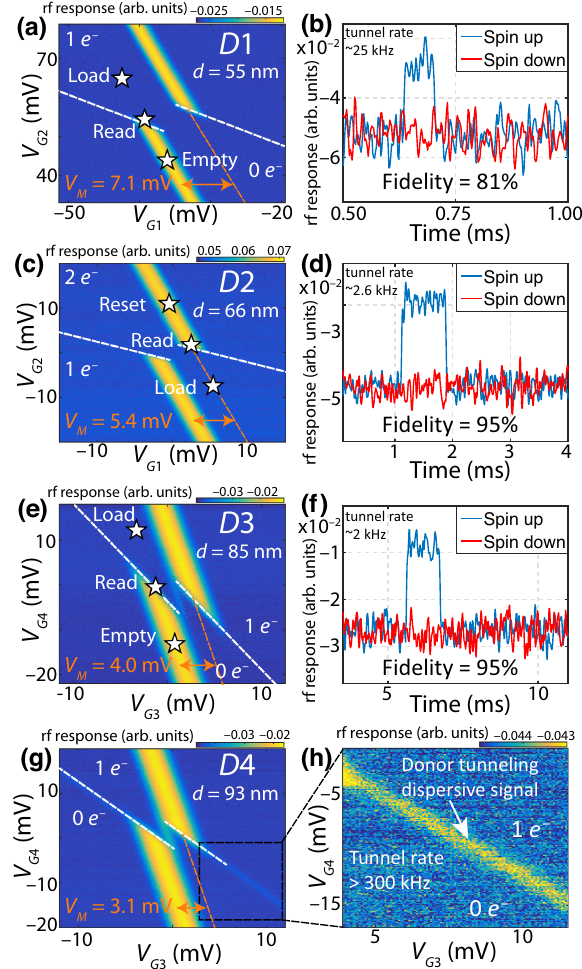
FIG. 2. Single-shot electron spin readout on D 1, D 2, and D 3 donor quantum dots. (a) Gate-gate map showing break in SLQD1 transition line when the first electron is loaded onto D 1. The approximate pulse positions for the readout sequence are indicated by the white stars. The read level is calibrated so that a spin-up electron can tunnel from D 1 to R 1, but a spin-down cannot. (b) Example single-shot readout traces showing spin-up and spin-down signals. Due to the fast tunnel rate at this transi- tion, some of the rapid spin-up traces are not registered, leading to an average fidelity of 81%. (c) Similar gate-gate map for D 2. Readout for D 2 is performed at the second electron transition via the D − charge state [29]. Here we choose the read position on the opposite side of the SLQD charge break to make spin up the high sensor level for consistency with D 1 and D 3. (d) Example single-shot readout traces for D 2. (e) Gate-gate map for D 3. (f) Example single-shot readout traces for D 3. (g) Gate-gate map for D 4. For this donor quantum dot, the tunnel rate between the donor and reservoir is too fast to perform single-shot spin readout. In fact, a faint signal can be observed due to cyclical driving of an electron between the D 4 and R 2. This implies that the tunnel rate is non-negligible compared to the rf reflectrome- try frequency (130 MHz). (h) Enlargement of the region from (g), highlighting the dispersive signal generated by cyclical tunneling of the D 4